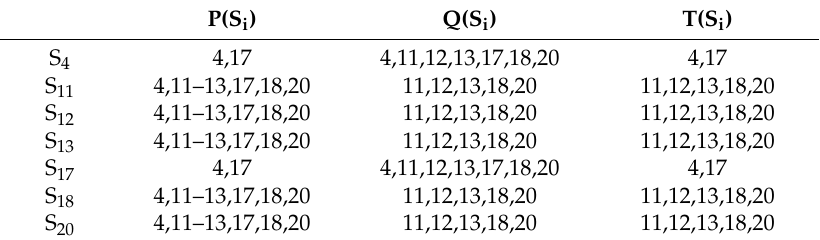
Table 11. Sixth level of reachability set, leading set, and their intersection.